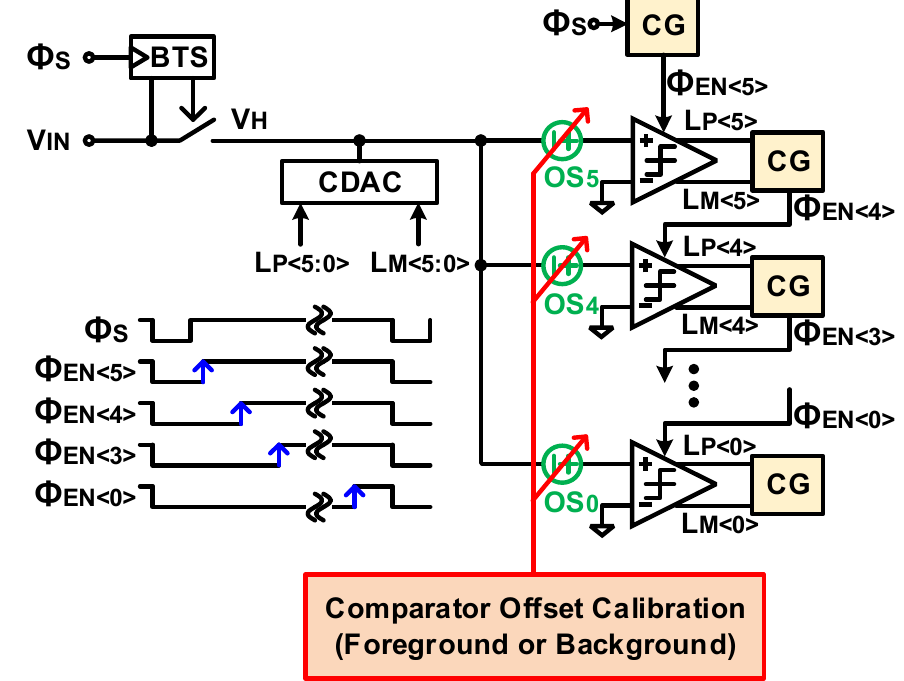
Figure 1. Conceptual block and timing diagram of conventional LU SAR ADC [15–20].